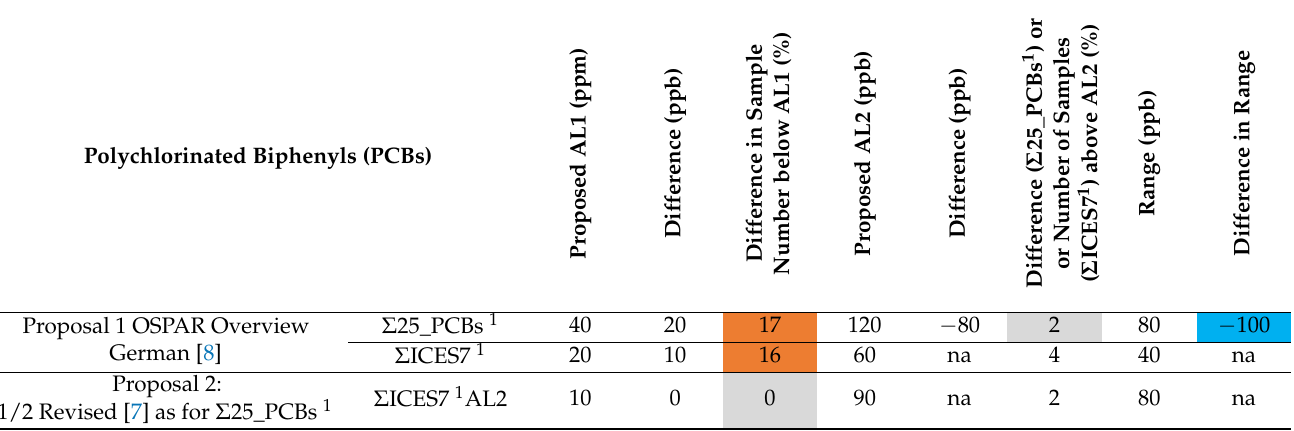
Table 17. Polychlorinated biphenyls (PCBs)—Summed PCBs— Σ 25_PCBs and Σ ICES7—Difference (proposed − current) in the percentage of samples below AL1; above AL2 for the proposed ALs and range of values between AL1 and AL2. Please note there is no current AL2 for Σ ICES7, and values (green) are more protective and values (orange) are more permissive (colour codes defined in Tables 2 to